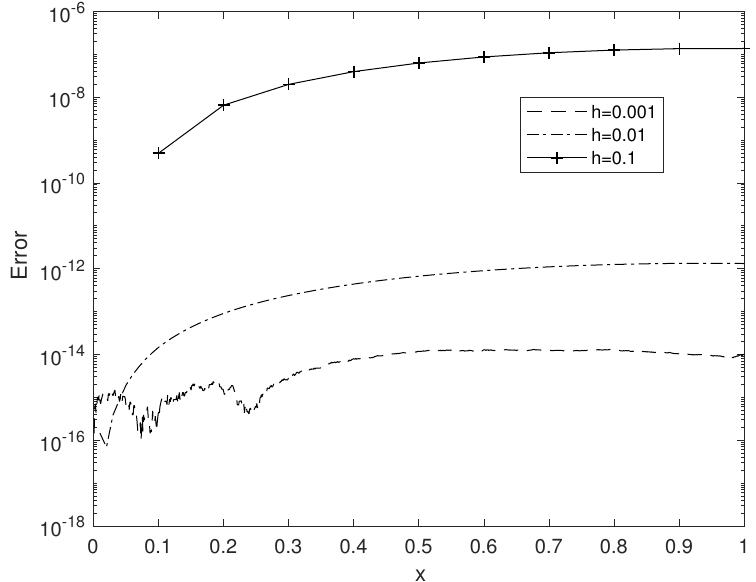
Figure 3. Approximation errors ( m = 7) for the matrix problem (34) with various step sizes.